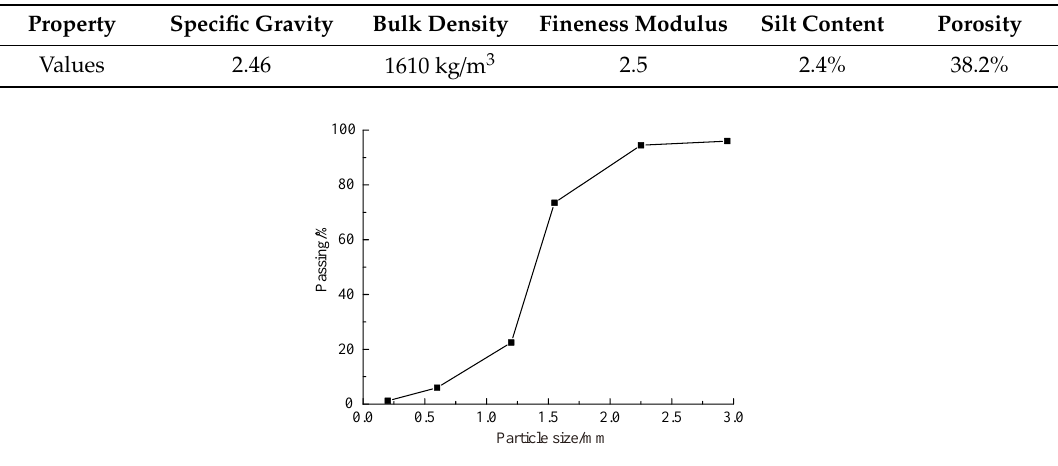
Figure 1. Particle size distribution of the river sand. Table 4. Mechanical properties, energy storage and dissipation of mortar